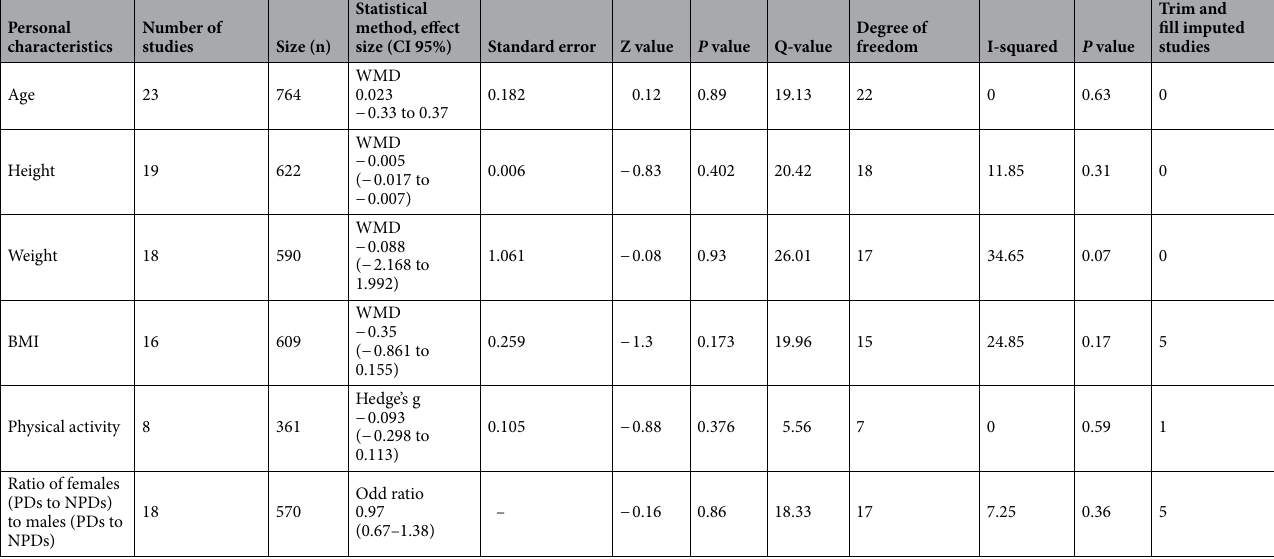
Table 2. The meta-analysis of PDs and NPDs’ personal characteristics. BMI body mass index, CI confidence interval, WMD weighted mean